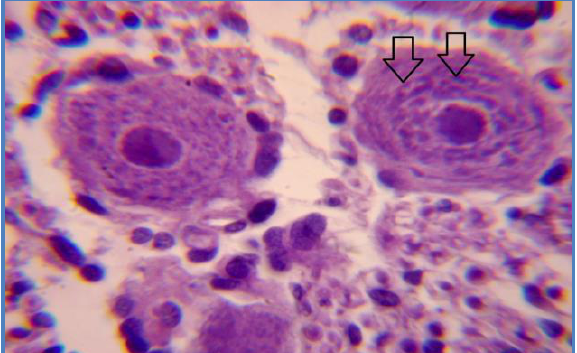
Figure, 5: Adult group sensory neurons, normal staining and Nissl granules appeared very clear (arrows). 100X. H and E.